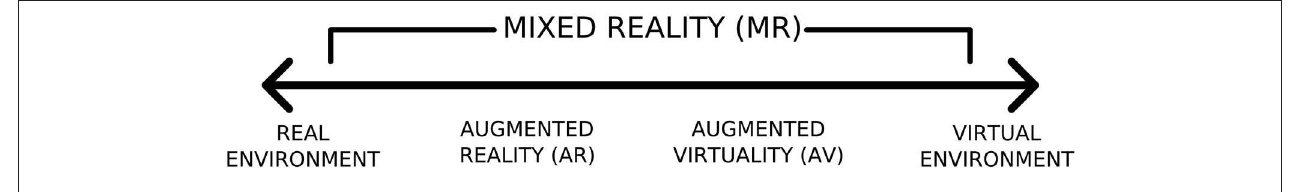
FIGURE 1 | Milgram’s continuum (Milgram and Kishino, 1994).